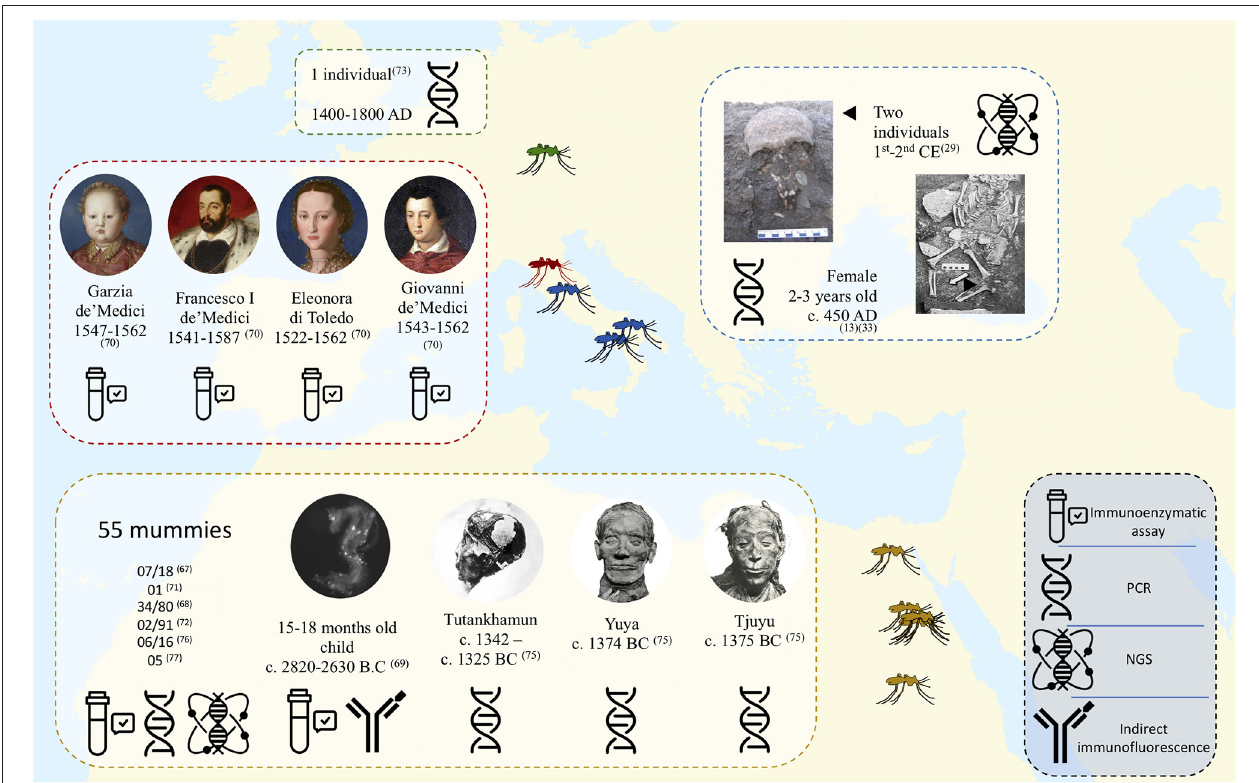
FIGURE 4 | Map showing the major works carried out for the diagnosis of ancient malaria. all identified Plasmodium belong to the species falciparum except for one individual tested in Bavaria ( 73) and one Egyptian mummy (71) whose pathogen is Plasmodium